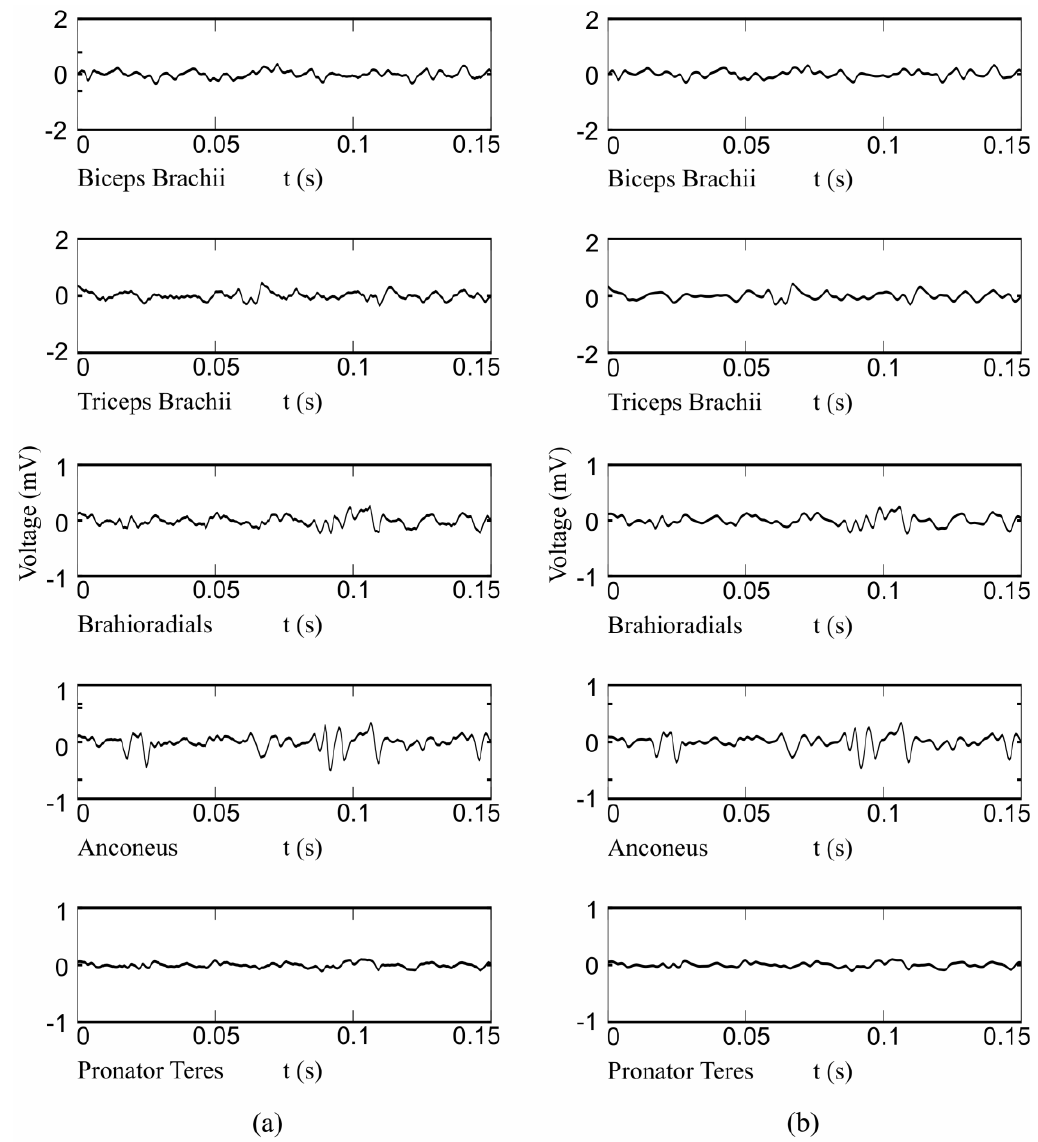
Figure B4. Example of recorded EMG signals from five muscles (biceps brachii, triceps brachi, brachioradialis, anconeus, bracioradialis, and pronator teres) during supination. Figure shows ( a ) raw signals and ( b ) signals filtered using 4th order Butterworth filter with the cut-off frequencies of 15 Hz and 350 Hz